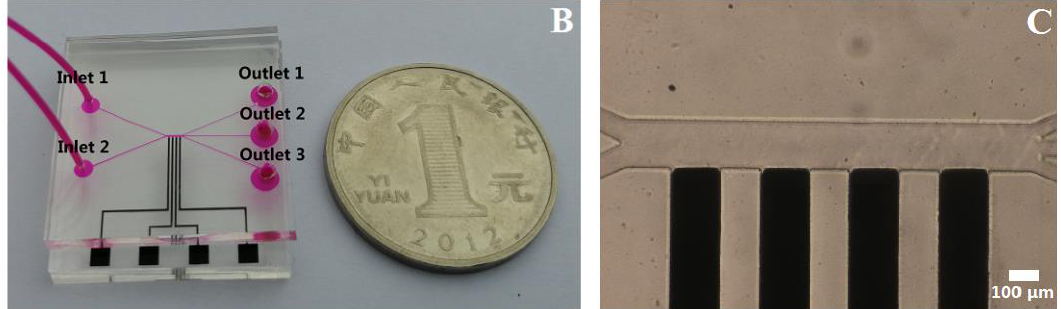
Figure 2. ( A ) Micromachining flowchart for fabricating a microfluidic device with 3D electrodes. ( B ) Micrograph of the microfluidic chip with the composite 3D electrode. The channel and electrode widths were both 200 μm. ( C ) Photograph of a microfluidic chip.